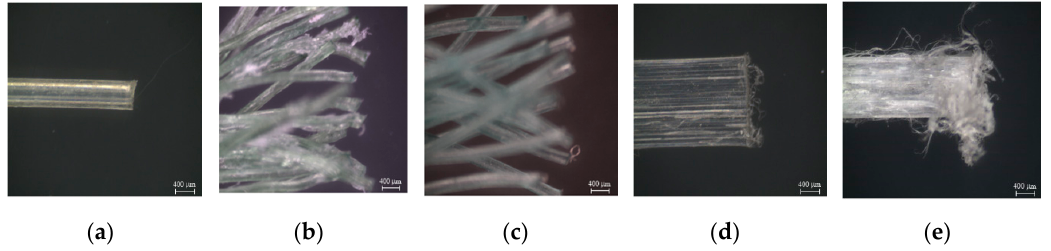
Figure 11. Ends of the macro-fibers after the pullout testing: ( a ) WFN1; ( b ) WFN2; ( c ) WFN3; ( d ) CP1; ( e ) CP2.